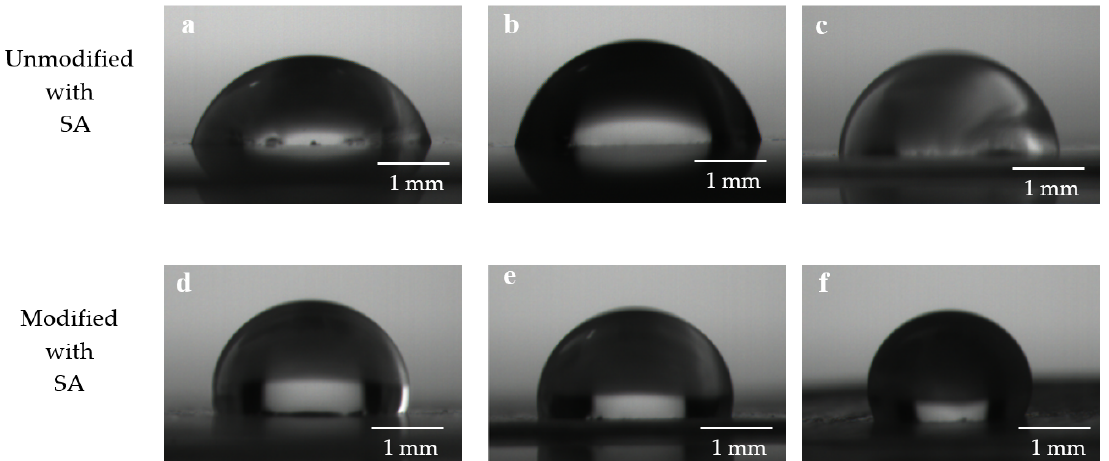
Figure 2. Wettability of water droplets on the surface of the copper sheets. ( a , d ) The contact angle (CA) of L 0 = 3.3 µ m; ( b , e ) the CA of L 0 = 2.4 µ m; ( c , f ) the CA of L 0 = 1.6 µ m.